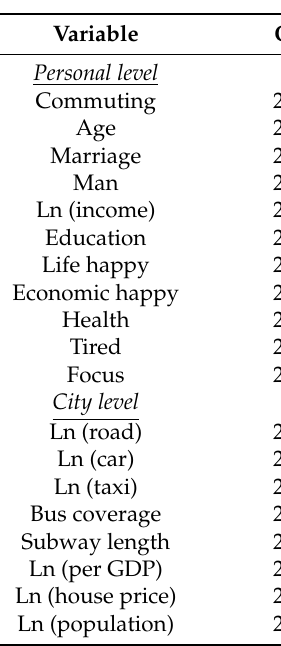
Table 2. Descriptive statistics.